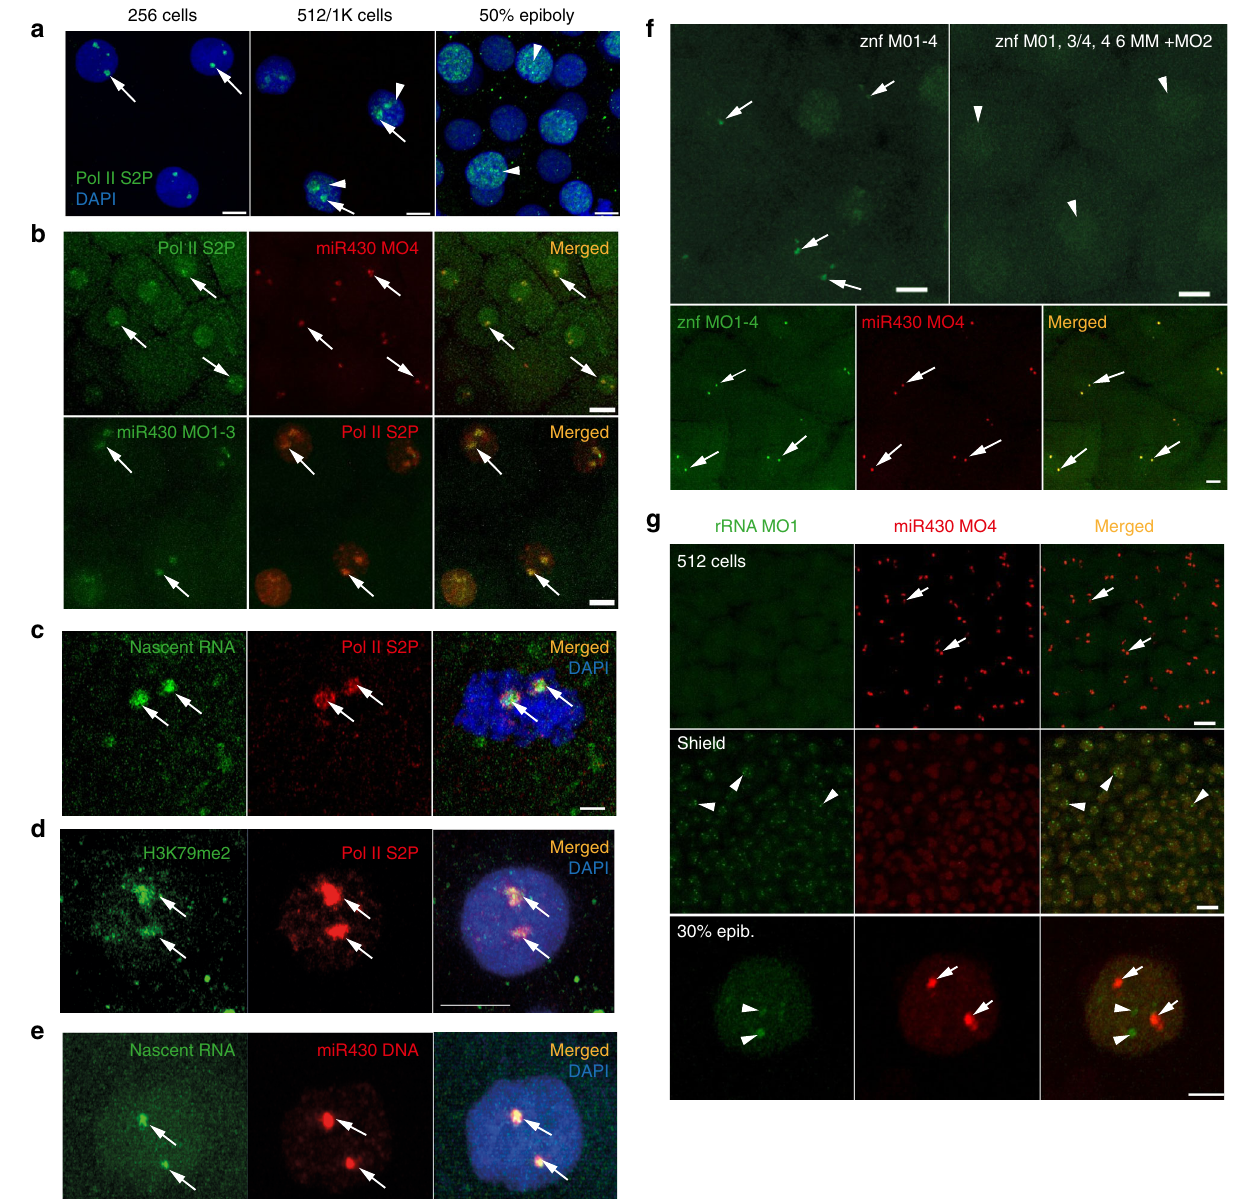
Fig. 5 First wave transcription con fi ned into a nuclear compartment. a Immunohistochemistry of Pol II S2P (green) with two main foci (arrows) and broader distribution (arrowheads) at indicated stages. Nuclei DAPI stained (blue). b Top: live imaging of embryos at 256-cell stage, injected with anti Pol II Ser2P Alexa Fluor 488 fab fragments (green) and Cy5-labelled miR430 MO4 (red). Green and red signals colocalise in all nuclei, with both signals detected ( n = 3 embryos). Bottom: immunohistochemistry of Pol II S2P (red) and miR430 MO1-3 (green) at high stage; green and red signals colocalise in all nuclei (3 embryos). c Immunohistochemistry of Pol II S2P (red) and nascent RNA detection (green) by ethynyl-uridine (EU) incorporation and Alexa Fluor 488 tagging at 256-cell stage. Green and red signals colocalise in all nuclei (49 nuclei, 6 embryos). d Immunohistochemistry for H3K79me2 (green) and Pol II Ser2P (red) and merged image with DAPI (blue) of 512-cell stage embryos. Third panel shows merge with DAPI (8 nuclei, 3 embryos). e Staining for the miR430 locus (red) in combination with nascent RNA detection (green) by EU at 512-cell stage. Merged panel shows DAPI in blue ( n = 37 nuclei, 3 embryos). f Top panels: live detection of activity of a cluster of znf genes at 512-cell stage by fl uorescein-labelled MOs, injected with mix of targeting (left) or mismatch-containing MOs (right) ( n = 3 embryos each). Bottom panels: embryo co-injected with miR430 MO4 (red) and znf targeting MOs (green) at 256-cell stage. Green and red signals colocalised in all nuclei ( n = 6 embryos). In panels ( b – f ) arrows point at transcription foci. g Top: Airyscan images of embryo (at 512-cell and shield stages) co-injected with MOs targeting the 5 ′ ETS of 45 S ribosomal RNA precursor (green) and miR430 MO4 (red) ( n = 4 embryos for each stage). Bottom: confocal Airyscan image of 30% epiboly embryo injected with the same reagents. miR430 MO4 signal accumulation (arrows) and rRNA_5 ’ ETS_MO1 (arrowheads) are indicated. znf zinc fi nger gene, Pol II S2P RNA polymerase II serine-2 phosphorylated, rRNA ribosomal RNA, ETS external transcribed spacer, Scale bars ( µ m): a 10, b top 20, bottom 10, c 2, d , e 5, f 10, g top 20, bottom